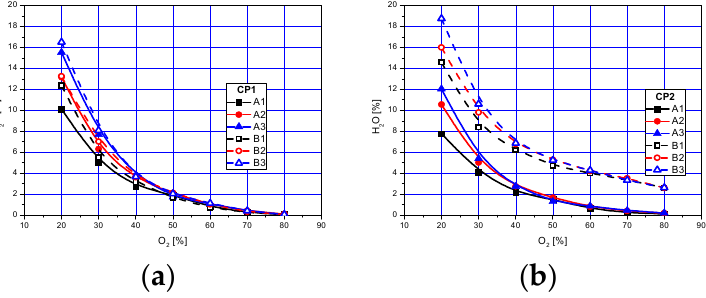
Figure 6. Changes in averaged values of molar fractions of H 2 O in the planes CP1 ( a ) and CP2 ( b ) with respect to oxygen concentration for variants A1 , A2 , A3 , B1 , B2 , B3 .